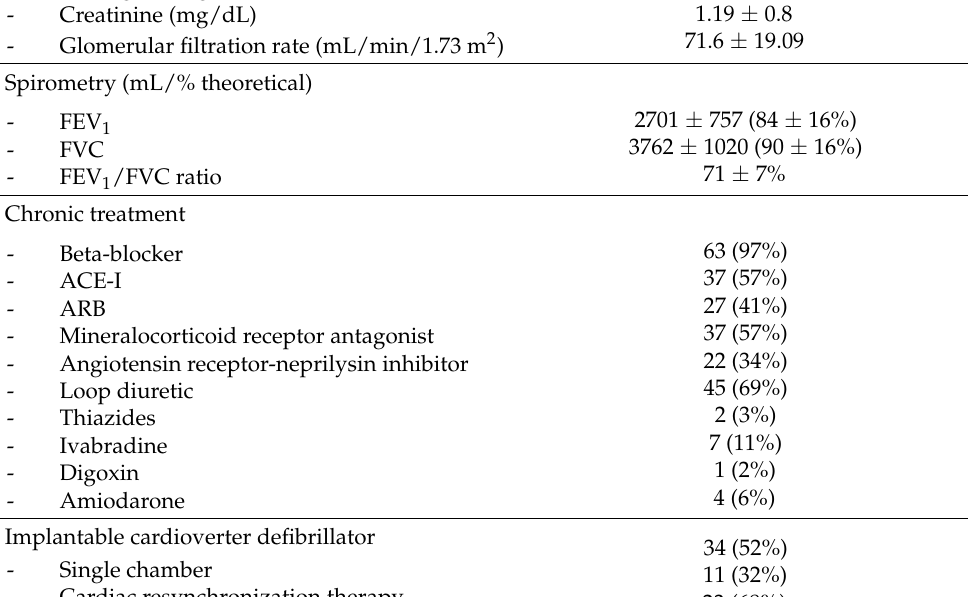
AT 1 -receptor blocker. Comorbidities included atrial fibrillation with controlled ventricular response in 12 (18%) patients and COPD in 18 (28%) patients. COPD was mild and moderate in 44% and 50% of the patients,